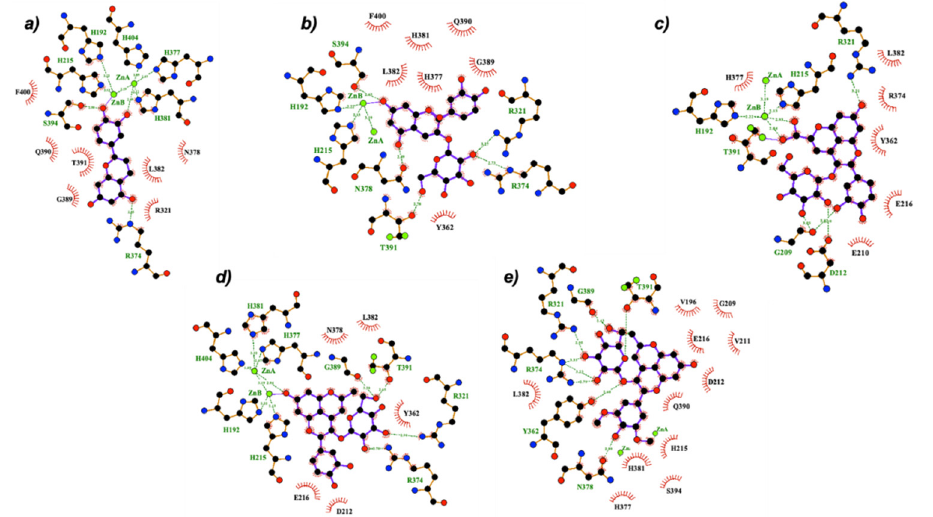
Figure 5. 2D representation of the best docking pose of some representative compounds towards the active site of hTYRP1: ( a ) 1-A, ( b ) 3-B − , ( c ) 5, ( d ) 7, and ( e ) 8. LigPlot was used for diagram rendering [45]. The 3D poses arthe active sie depicted in Figure S3.